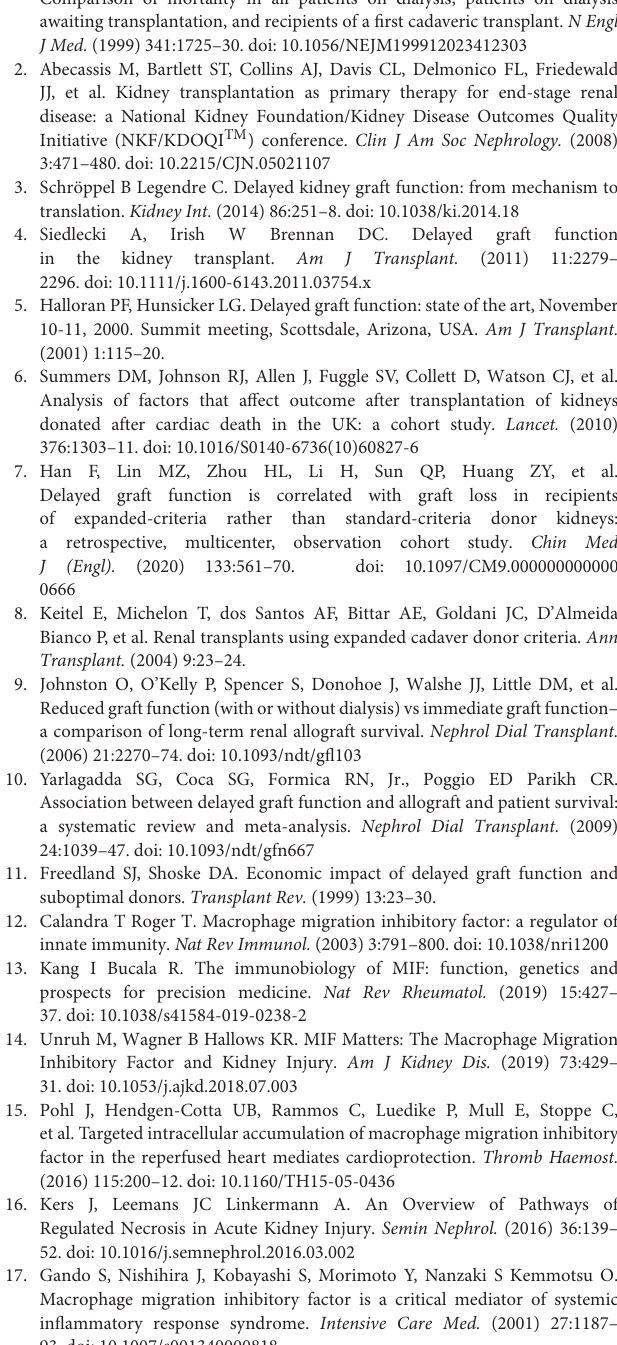
Supplementary Table 1 | Summary of characteristics in recipient and donor, stratified by recipients’s allograft